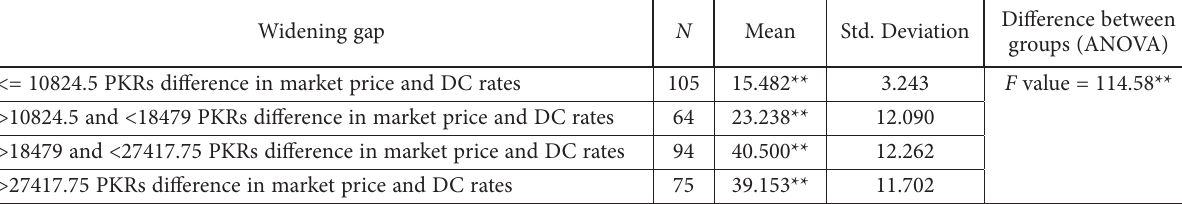
Table 8. Association between the widening gap and incidence of under invoicing (source: author’s calculation) Widening gap N Mean Std. Deviation